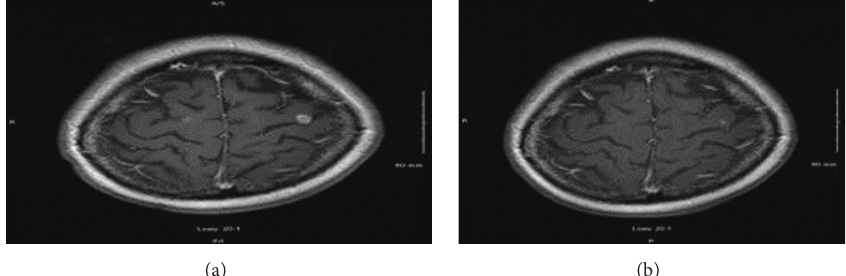
Figure 2: (a, b) Brain metastasis regression after 4 cycles of irinotecan: (a) prechemotherapy and (b) postchemotherapy.